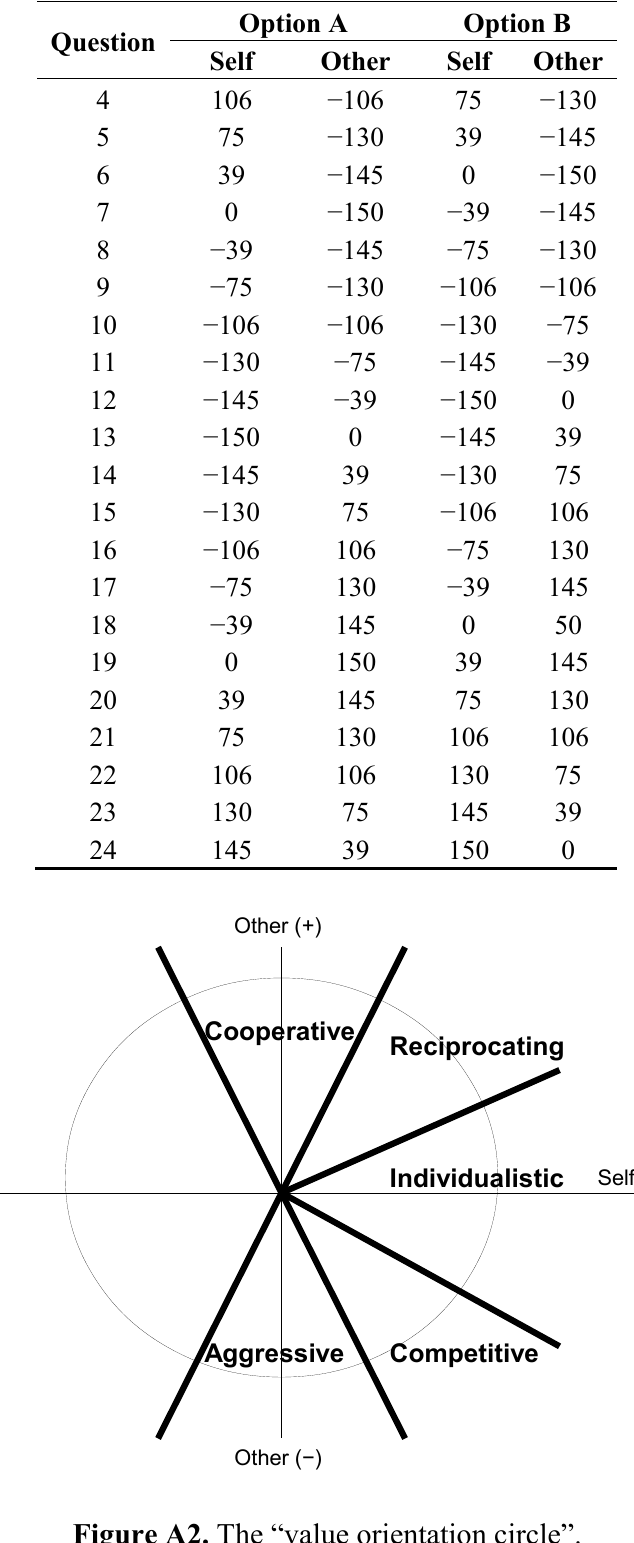
Figure A2. The “value orientation